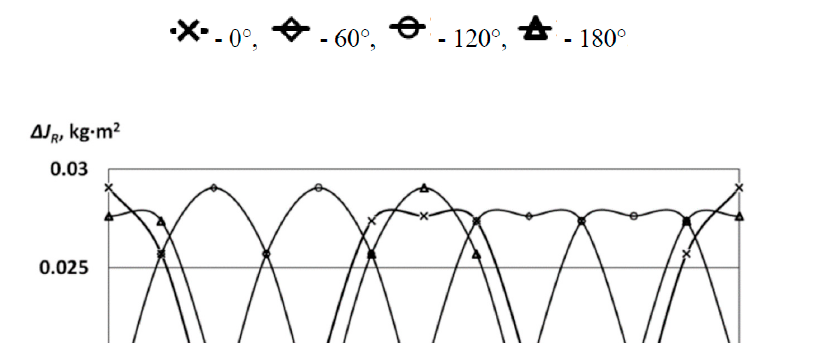
9 of 30 Figure 7. ( a ) Kinematic scheme of V-shaped ICE: 1—crankshaft, 2 and 4—couplers, 3 and 5—pistons [26]. Figure is reprinted with permission from publisher. Figure 8 depicts the amplitude of balancing moments of inertia (𝛥𝐽 (cid:3019) ) and coefficient of mechanical losses (𝐾 (cid:3014)(cid:3013) ) for 0° ≤ 𝑎 (cid:3030)(cid:3052)(cid:3039) ≤ 360° . Each curve exhibits the dynamic behavior with respect to the angle between the cranks (𝑎 (cid:3030)(cid:3045) ) , ranging from 0° to 180°. As can be seen in Figure 8a, the maximum amplitudes of the moment of inertia occurred at 𝑎 (cid:3030)(cid:3045) = 𝑎 (cid:3030)(cid:3052)(cid:3039) + 0° or (cid:3399) 180° . This